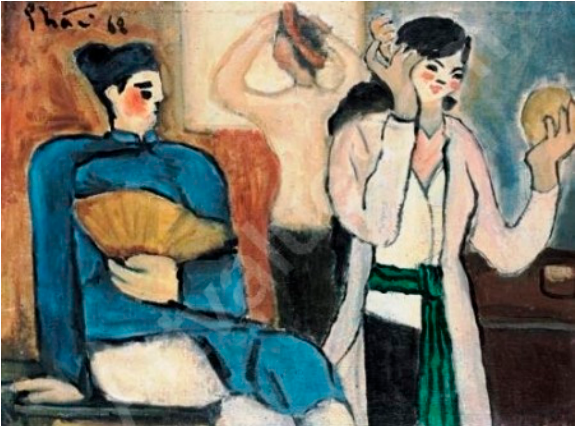
Figure A10. Cheo Actor —Bui Xuan Phai. Auctioned at Sotheby’s, October 2008. The image was sourced from Thanh Nien Newspaper (Nguyen 2016a).